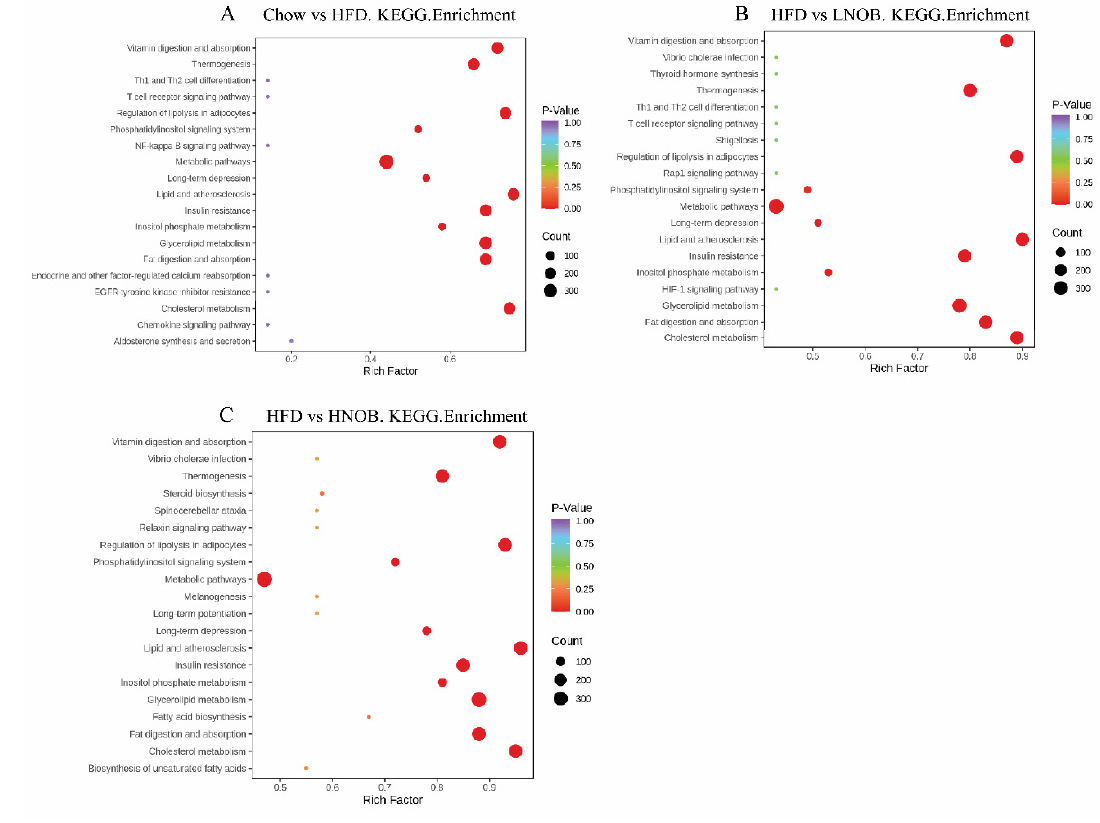
Figure 5. Lipid metabolic pathway analysis based on markedly differential lipid species in Chow vs. HFD ( A ), HFD vs. LNOB ( B ), and HFD vs. HNOB ( C ). Degree of enrichment was analyzed by a rich factor, p -value, and the number of lipid metabolites enriched in each pathway. The size of the bubble shows the number of markedly differential lipid species that are enriched in this pathway, and the point with a different gradation of color represents the scope of the p -value. A higher rich factor value stands for a higher degree of enrichment, and a lower p -value represents a more significant degree of enrichment.